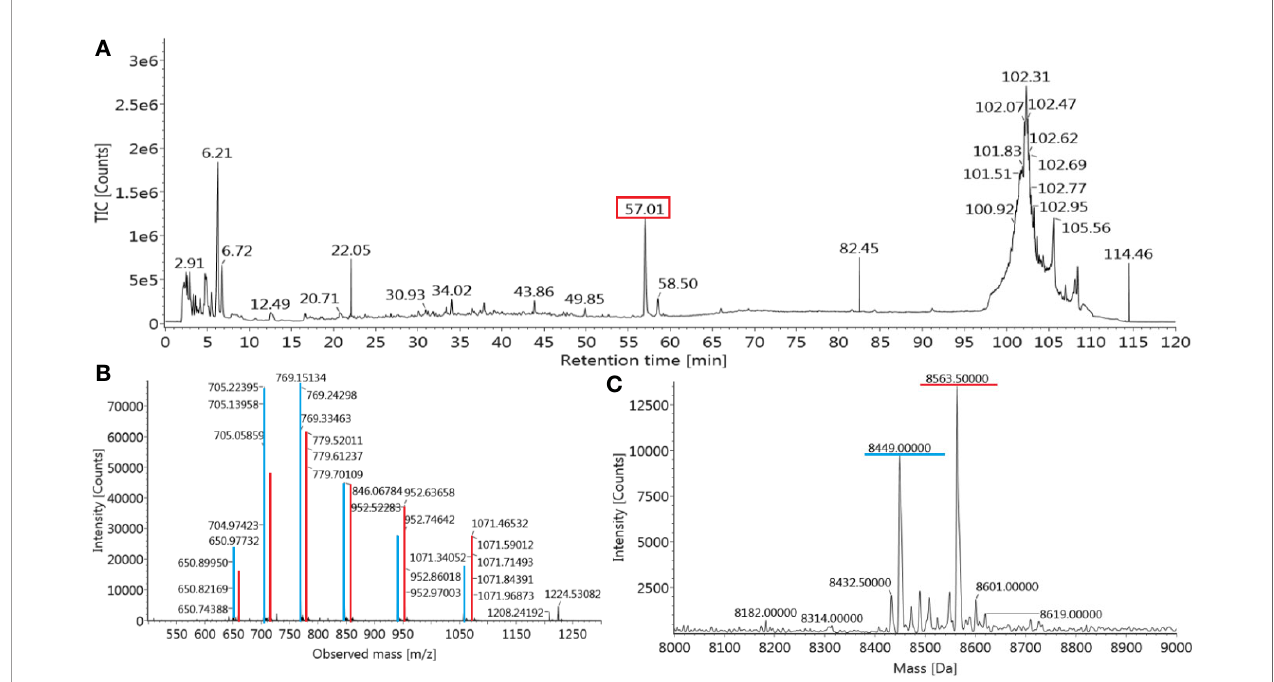
FIGURE 5 | Identi fi cation of monomeric Ub in Transferon. (A) Transferon (Batch 18A01; 2 mg/mL) was analyzed by ESI-IMS-Q-ToF using an intact mass approach with a small-particle size column (CSH C18, 1.7 m m). The most intense m/z signal of the total ion counting (TIC) pro fi le was observed at 57.01 min (red square). (B) The m/z pro fi le and (C) the deconvoluted mass of the main Transferon TIC signal (marked in red) was similar to the theoretical values of monomeric Ub. A second peptide entity with a mass close to monomeric Ub (8449.0 Da) was also observed in the main chromatographic peak ( m/z transitions in